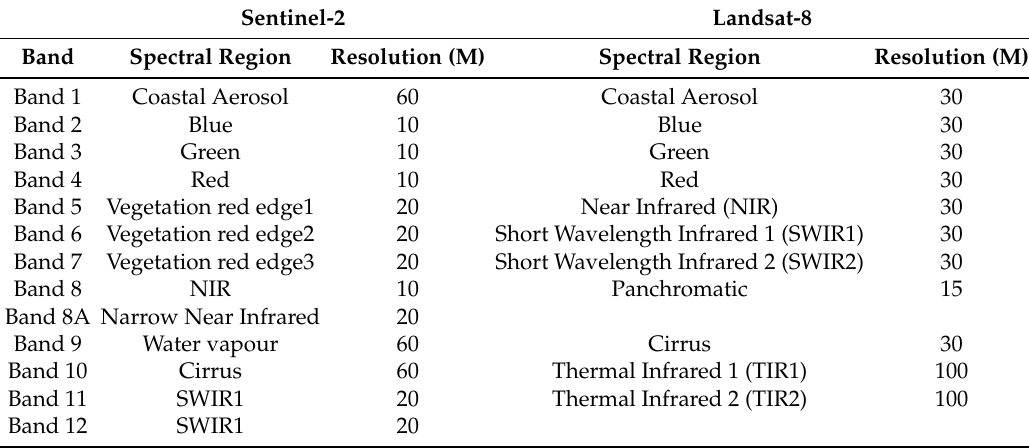
Table 1. Spectral region and spatial resolution of the bands from Sentinel-2 and Landsat-8. Sentinel-2